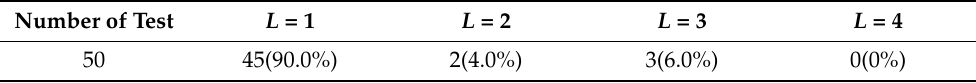
Table 3. Safety verification test results of a nine-degrees-of-freedom turntable rendezvous and